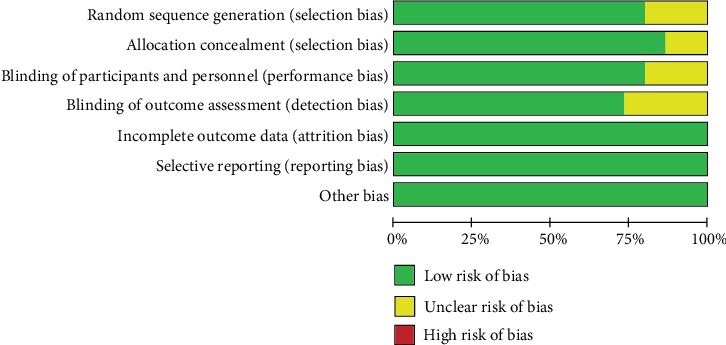
Risk of bias graph for the included studies.